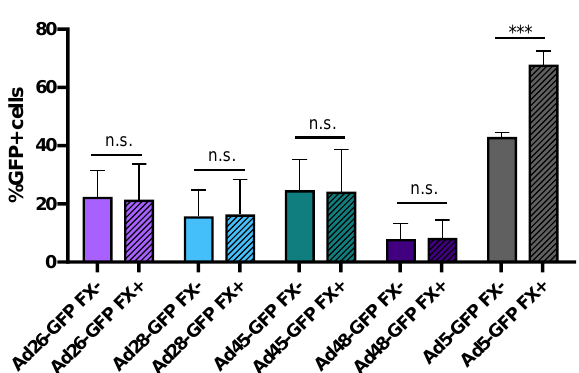
Figure 4. Hepatocyte transduction in the presence of blood coagulation factor X. The e ff ect of FX binding was measured by changes in hepatocyte transduction. Each recombinant adenovirus was preincubated with or without physiological levels of FX prior to infection of HepG2 cells at 500 vp / cell. Transduction was evaluated 24 h later by determining GFP + cells using flow cytometry. Data is presented as mean ± standard deviation (SD) from three independent experiments (n.s.—not significant, *** p < 0.001; Student’s t -test).